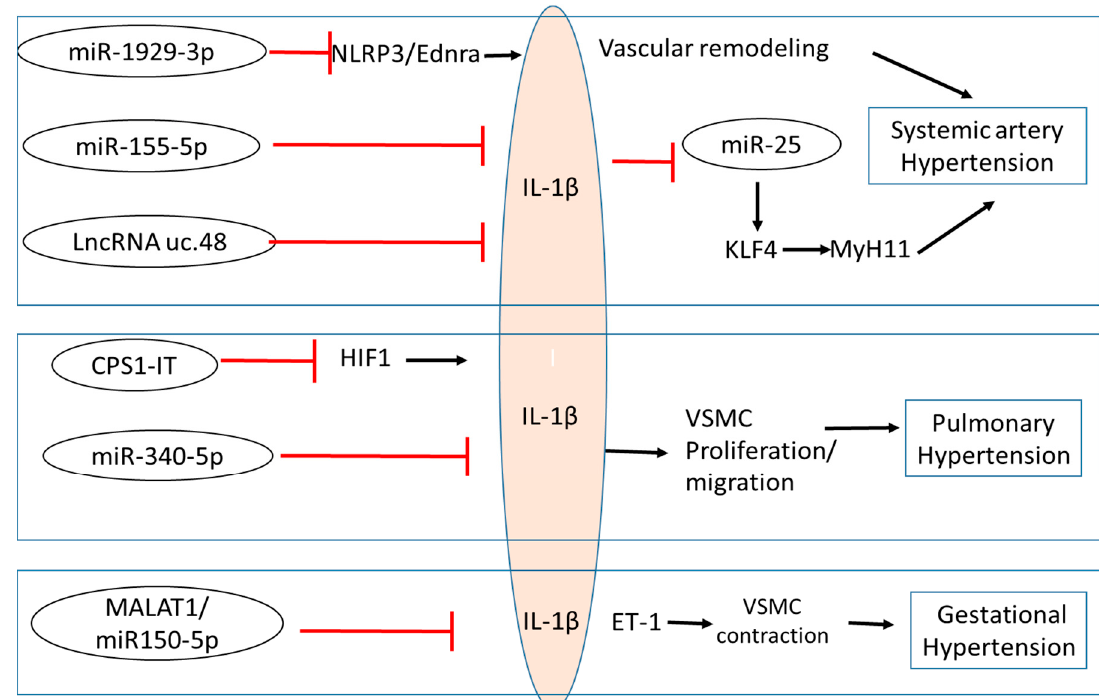
Figure 1. Non-coding RNA regulation of IL-1 β and its associated signaling in various hypertension conditions. Several ncRNAs function to block the pro-inflammatory actions of IL-1 β in the setting of systemic hypertension, pulmonary hypertension, and gestational hypertension. IL-1 β also inhibits miR-25 and is subsequently involved in the regulation of blood pressure. NLRP3: NLR family pyrin domain containing 3; ETRA: endothelin A receptor; KLF4: Kruppel like factor 4; HIF1: Hypoxia-inducible factors; ET1: Endothelin 1; CPS1-IT: CPS1 Intronic Transcript 1; MALAT 1: metastasis-associated lung adenocarcinoma transcript 1; VSMC: vascular smooth muscle